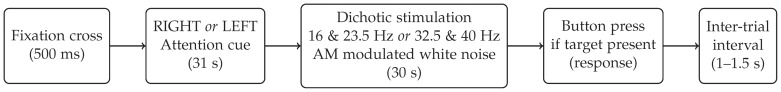
A depiction of the trial sequence.